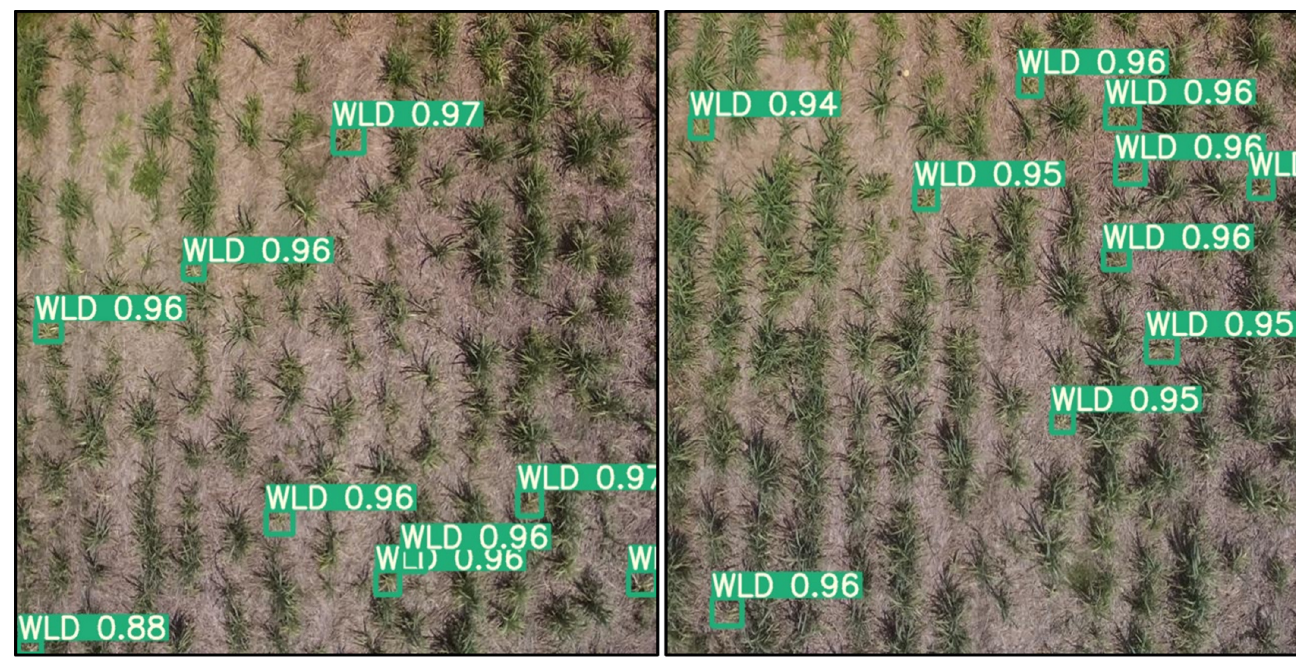
Figure 16. Bounding box detection using YOLOR.